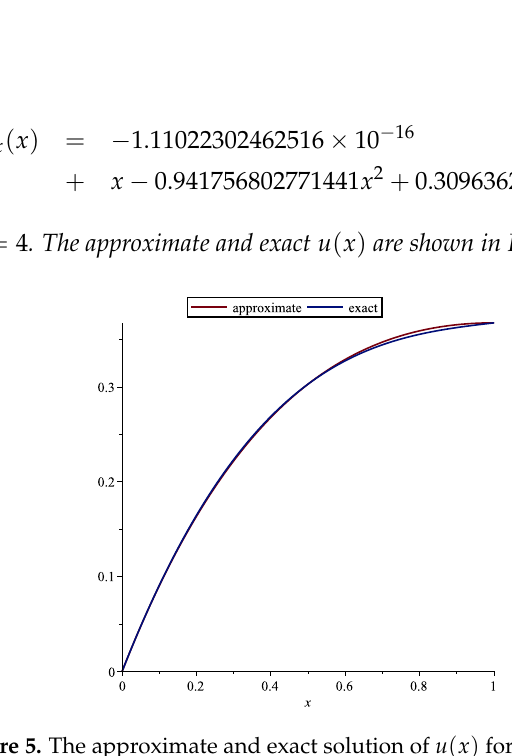
Figure 5. The approximate and exact solution of u ( x ) for Example 5.